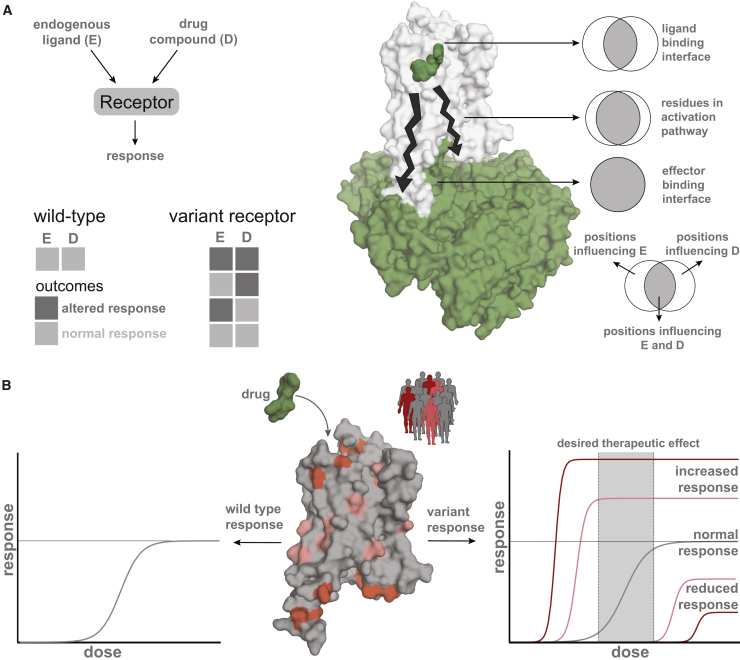
GPCR Variants Can Contribute to Altered Drug Response(A) Receptor response outcome upon binding to an endogenous ligand binding (E) and upon drug treatment (D). A receptor variant may induce phenotype-altering (e.g., disease) perturbations (endogenous ligand) and/or altered drug response (and combinations thereof). The position of the missense variation (top right) renders its effect. Some mutations may have no effect on the binding of the endogenous ligand or the drug and are entirely neutral. Mutations in/near the ligand-binding interface might affect endogenous ligand signaling, drug response, or both. Mutations in the effector-binding interface (G protein/arrestin) most likely affect both endogenous ligand signaling and drug response.(B) Differences in drug response due to different mutations between individuals in a population. The drug target variation spectrum may differently affect individual drug responses by potentially altering ligand potencies and efficacies, receptor conformation, surface expression, and/or biasing signaling. Personalized target sequencing could facilitate prognosis of a patient’s drug response. Additionally, pharmacological characterization of genetic variants that have been cataloged in humans could foster precision prescription.See also Figure S6.